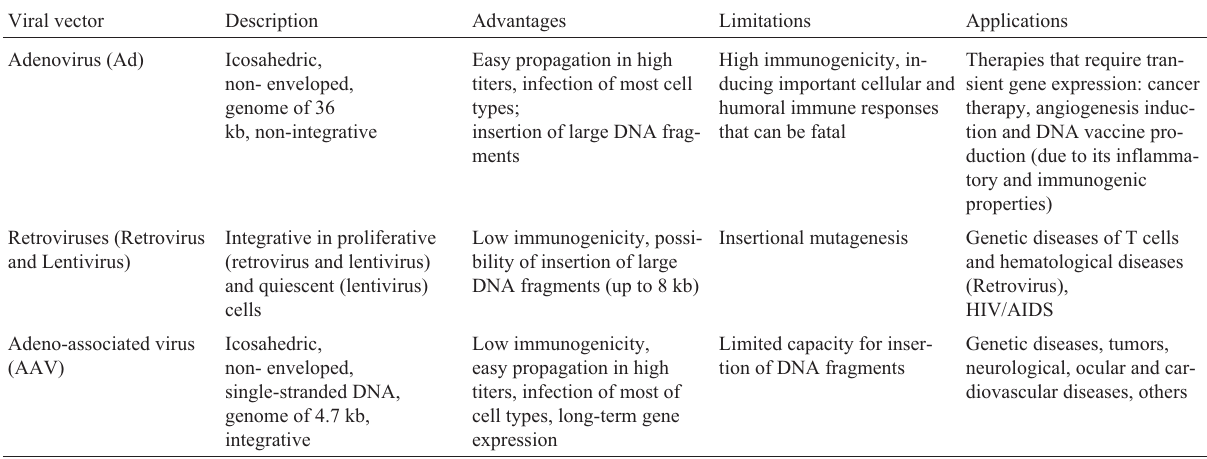
Table 3 - Main viral vector